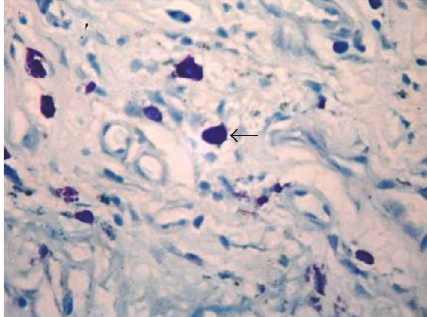
Figure 4: Photomicrograph of the section shows normal buccal mucosa (Toluidine Blue 10x). The arrows refer to mast cells.